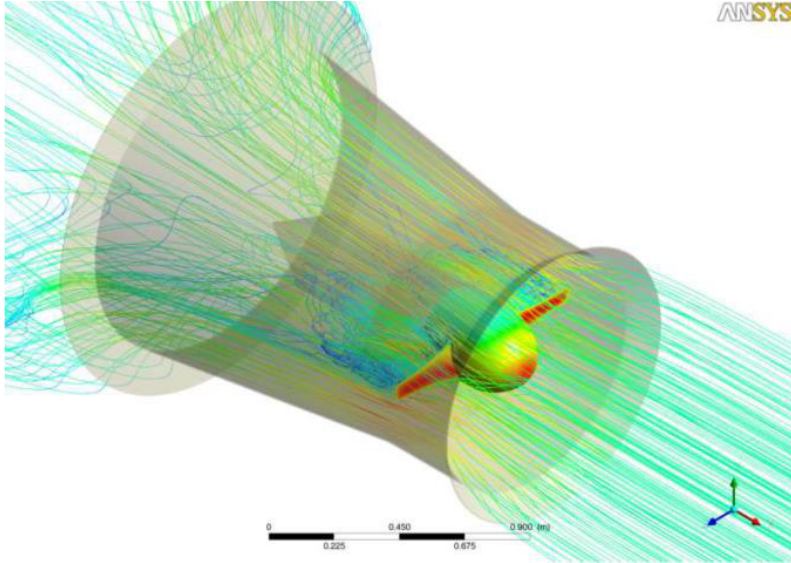
Figure 4. Surge channel to increase the flow speed.